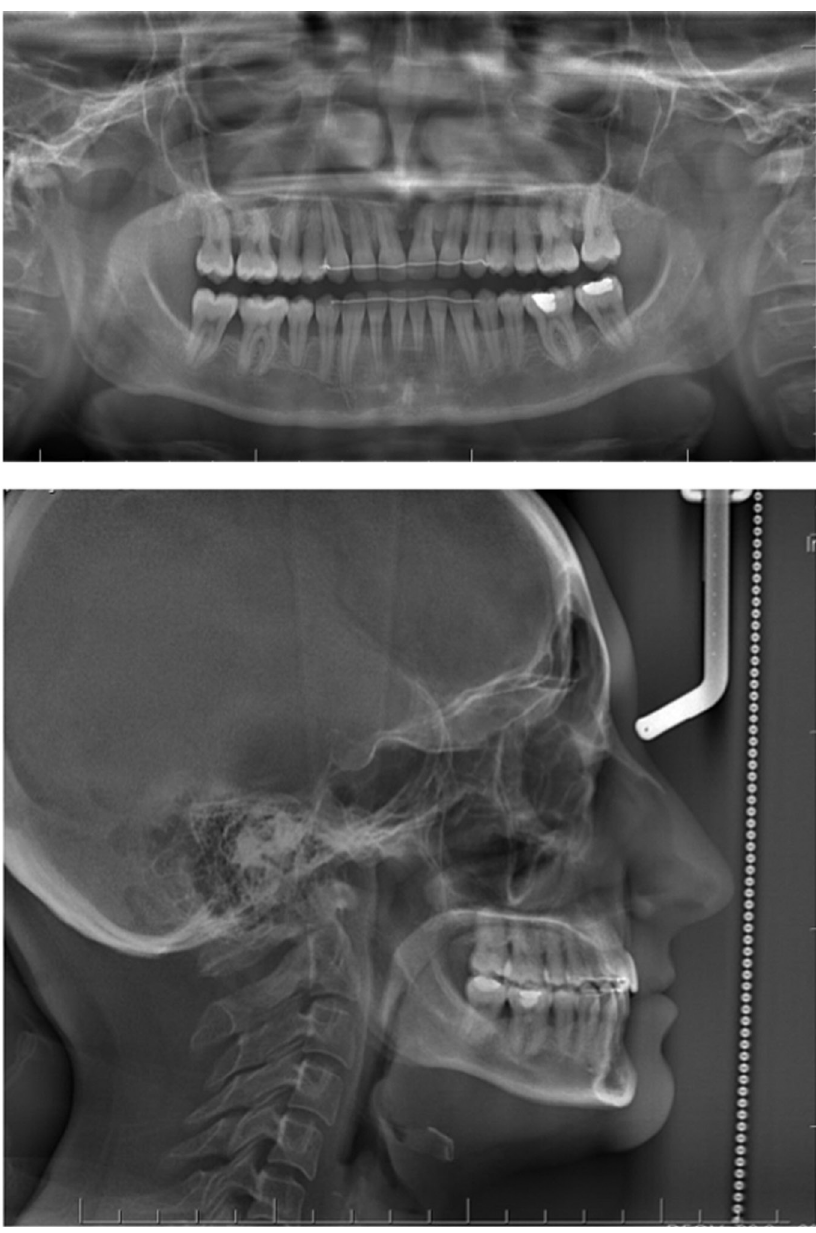
Figure 10. Panoramic X-ray and lateral cephalogram at 2-year